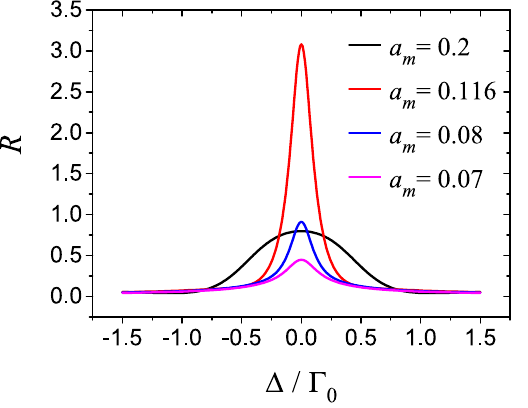
Figure 5. ( a ) The reflectivity plotted as a function of probe detuning under different values of a m . R m = 0.8; Other parameters are α =